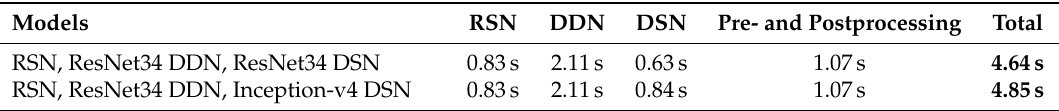
Table 7. PDDS inference speed, separated by different modules of the pipeline. For each column, the seconds taken per orthoframe is